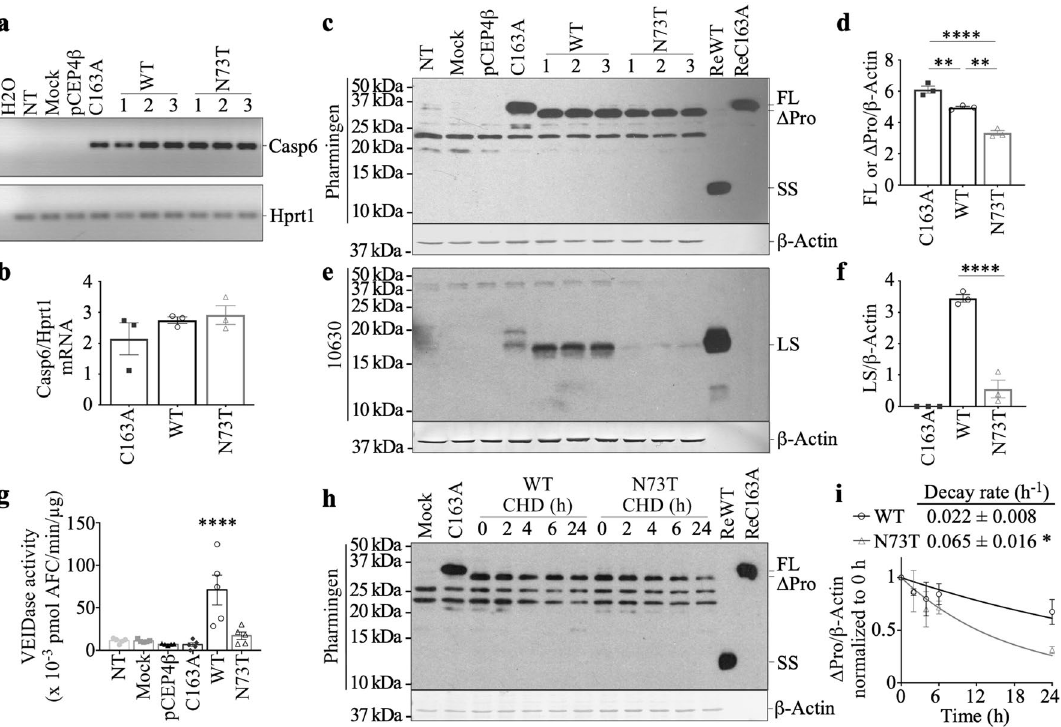
Figure 6. Steady levels of Casp6N73T and Casp6WT proteins in transfected HEK293T cells. ( a ) RedSafe- stained agarose gel of human Casp6 and Hprt1 mRNA amplicons in non-transfected (NT), mock, pCEP4β, pCEP4β-CASP6C163A-His, pCEP4β-CASP6WT∆Pro-His, or pCEP4β-CASP6N73T∆Pro-His-transfected cells. ( b ) Quantification of Casp6 mRNA levels normalized to Hprt1 shown in ( a ). ( c , e ) Western blot and ( d , f ) quantification of Casp6 in transfected cells against Pharmingen ( c , d ) or 10630 neoepitope antibodies ( e , f ). ReWT recombinant Casp6WT, ReC163A recombinant Casp6C163A, FL full length, ∆Pro Casp6 without pro-domain, SS small subunit, LS large subunit. Statistical evaluations were done with one-way ANOVA ( d , f : p < 0.0001) followed by post-hoc Tukey’s test (**p < 0.01, ****p < 0.0001). ( g ) VEIDase activity in protein extract from transfected cells. Statistical evaluations were done with one-way ANOVA (p < 0.0001) followed by post- hoc Tukey’s test. ****p < 0.0001 WT vs NT. ( h ) Western blot and ( i ) quantification of Casp6 in transfected cells with the Pharmingen antibody. The levels of ∆ProCasp6 normalized to the 0 h were fit to a one-phase decay to calculate the decay rate of Casp6WT or Casp6N73T. * indicates p = 0.012 done with unpaired t-test. Data shown represents mean ± s.e.m. from 3 independent experiments. Full-length images of blots/gels are presented in Supplementary